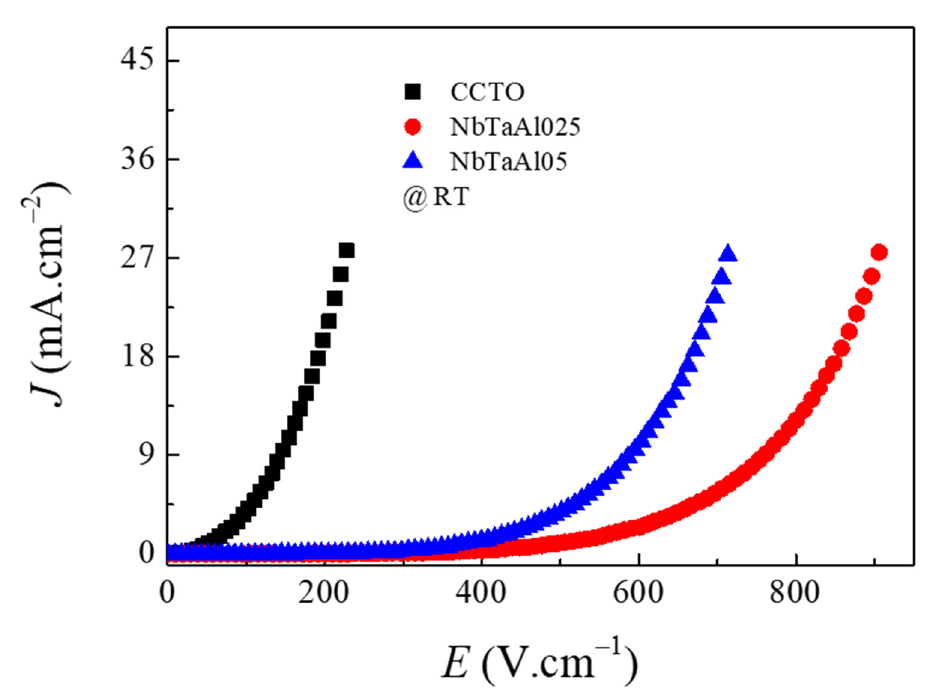
Figure 8. Nonlinear J – E characteristics of the CCTO, NbTaAl025, and NbTaAl05 ceramics at room temperature. Characterization of the electrical response of the grain boundaries was investigated under DC bias. As illustrated in Figure 9a, R gb of the NbTaAl025 decreased with increasing DC bias, indicating a decrease in φ b in the forward direction. At different DC bias levels, the temperature dependence of R gb for the NbTaAl025 ceramic was well fitted by the Arrhenius law. As demonstrated in Figure 9b, E gb of the NbTaAl025 ceramic decreased with increasing DC bias. The E gb values at 0, 10, 15, and 20 DC bias voltage were 0.642 ± 0.002, 0.636 ± 0.002, 0.625 ± 0.001, and 0.609 ± 0.001 eV, respectively. As can be seen in Figure 9b,